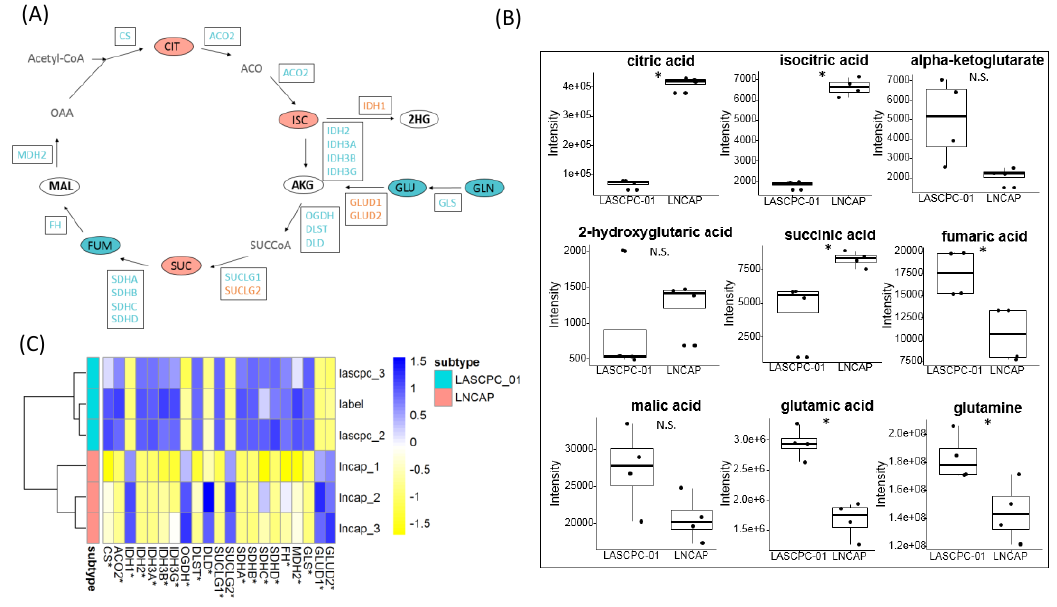
Figure 6. Tricarboxylic Acid ( TCA) cycle and citrate production of two cell lines. ( A ) Metabolites and genes involved in the TCA cycle; Blue: higher in LASCPC-01; Orange: higher in LNCAP; Bold: no significant difference; Grey: not detected. ( B ) Detected metabolites involved in the TCA cycle; *: p < 0.05; N.S.: no significant difference. ( C ) Detected transcripts involved in TCA cycle; *: p < 0.05.